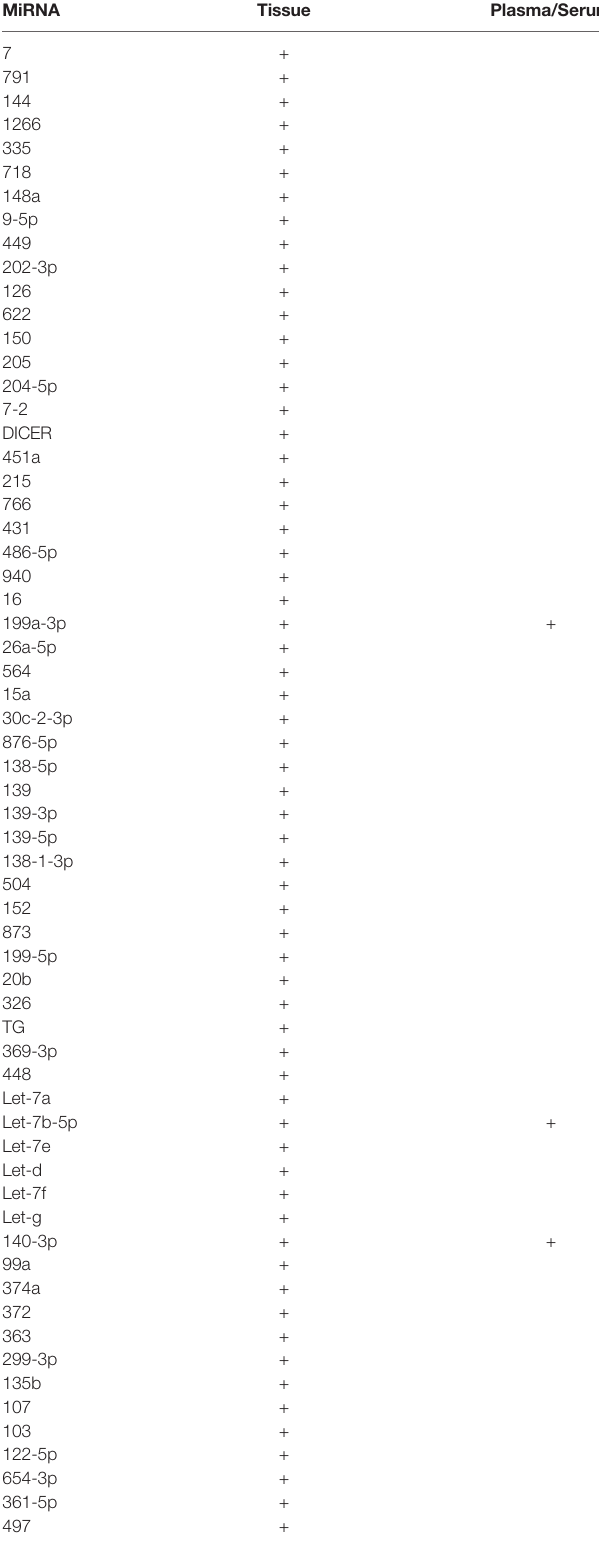
TABLE 2 | Downregulated miRNAs in papillary thyroid